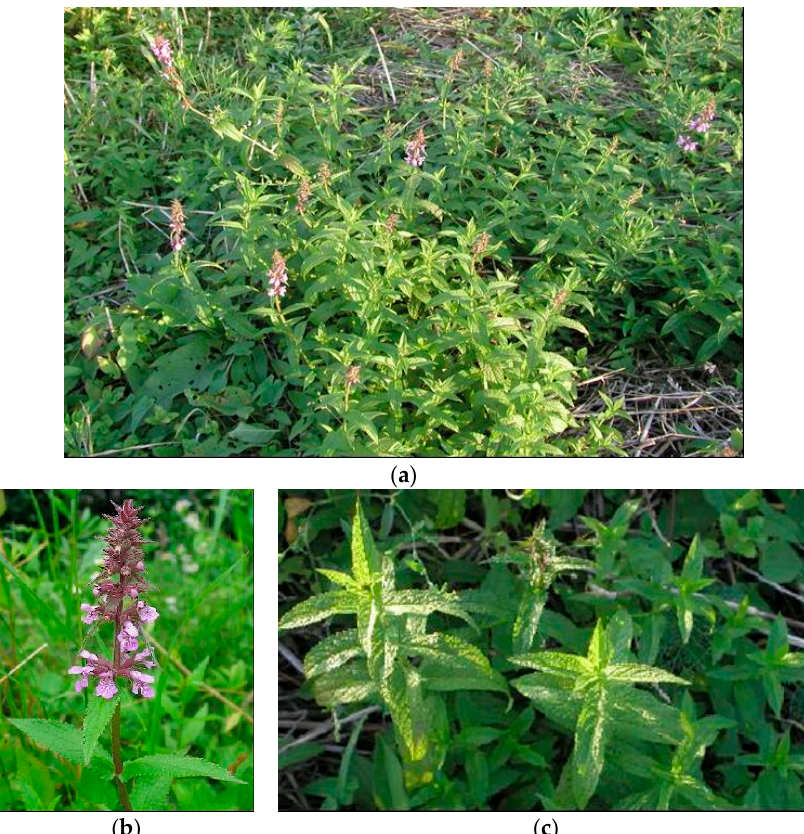
Figure 3. S. palustris L. ( a ) plant in flowering stage; ( b ) detail of the flower; ( c ) detail of leaf.